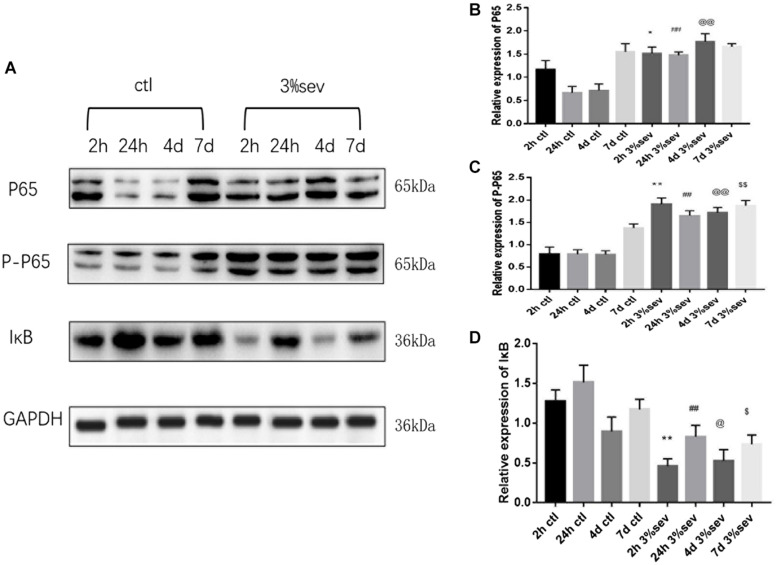
(A) Sevoflurane upregulated both P65 and P-P65 expression in DG region 2 h, 24 h, and 4 days after anesthesia, but only P-P65 expression 7 days after anesthesia. In contrast, sevoflurane decreased IκB expression in DG 2 h, 24 h, 4 days, and 7 days after anesthesia. (B) Quantification of P65. (C) Quantification of P-P65. (D) Quantification of IκB. n = 3. Values are presented as mean ± SD, n = 3; *P < 0.05 compared with 2 h control group, **P < 0.01 compared with 2 h control group, ##P < 0.01 compared with 24 h control group, @P < 0.05 compared with 4 days control group, @@P < 0.01 compared with 4 days control group, $P < 0.05 compared with 7 days control group, $$P < 0.01 compared with 7 days control group. One-way ANOVA with Newman–Keuls post hoc test or Kruskal–Wallis with Dunn’s Multiple comparison test was used for data analysis.